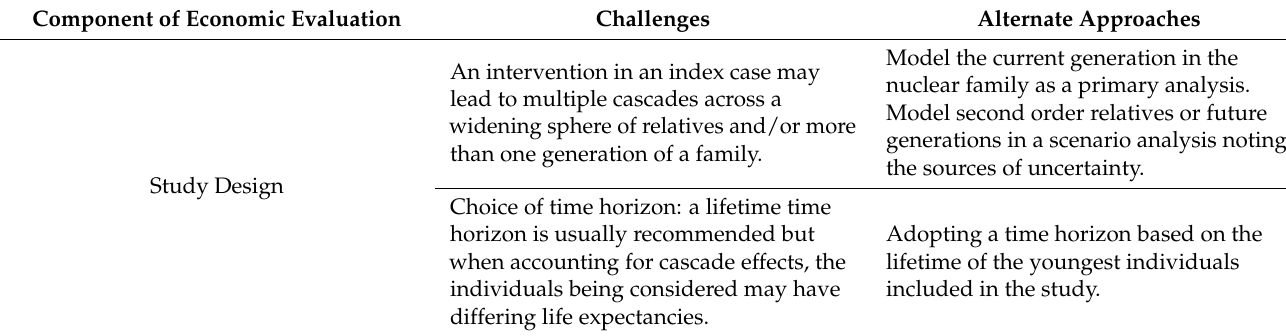
Figure 2. Challenges to economic evaluation methodology associated with incorporation of cascade effects in analysis. Table 2. Summary of methodological challenges of incorporating cascade effects in economic evaluation and suggestions for alternate